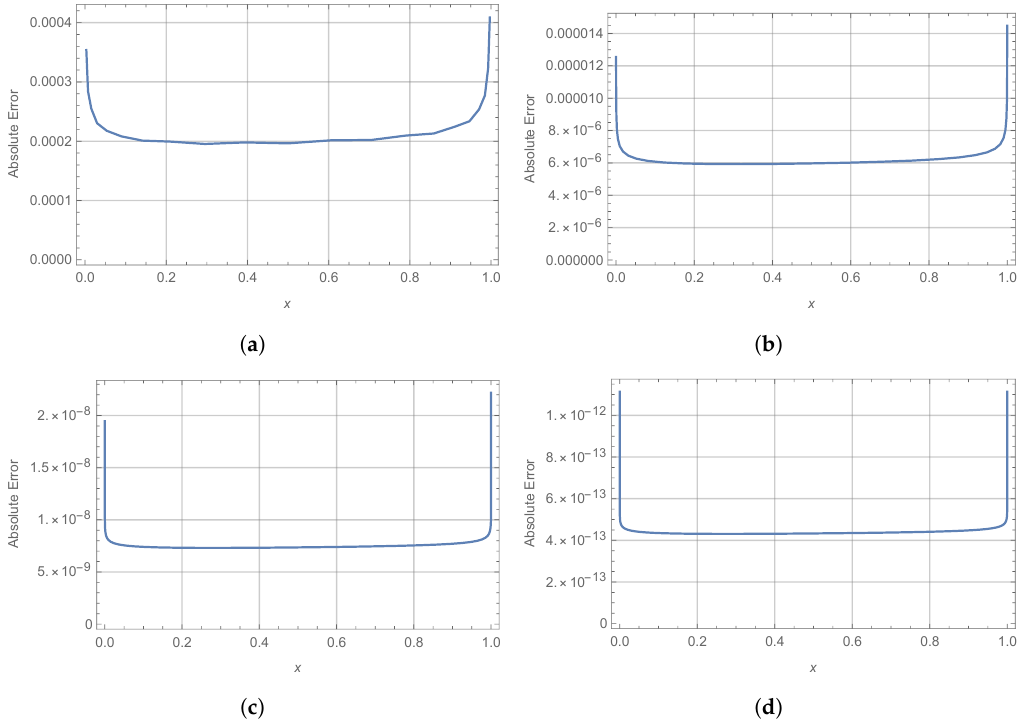
Figure 2. Plots of the absolute error of y (cid:48) ( x ) for Example 1 using the sinc-derivative interpolation for various values of N . ( a ) N = 10; ( b ) N = 15; ( c ) N = 25; ( d ) N = 40.